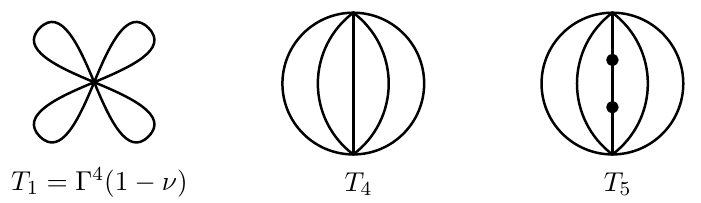
Figure 2 . Master integrals. Solid lines correspond to the propagators 1 = ( k 2 (cid:0)